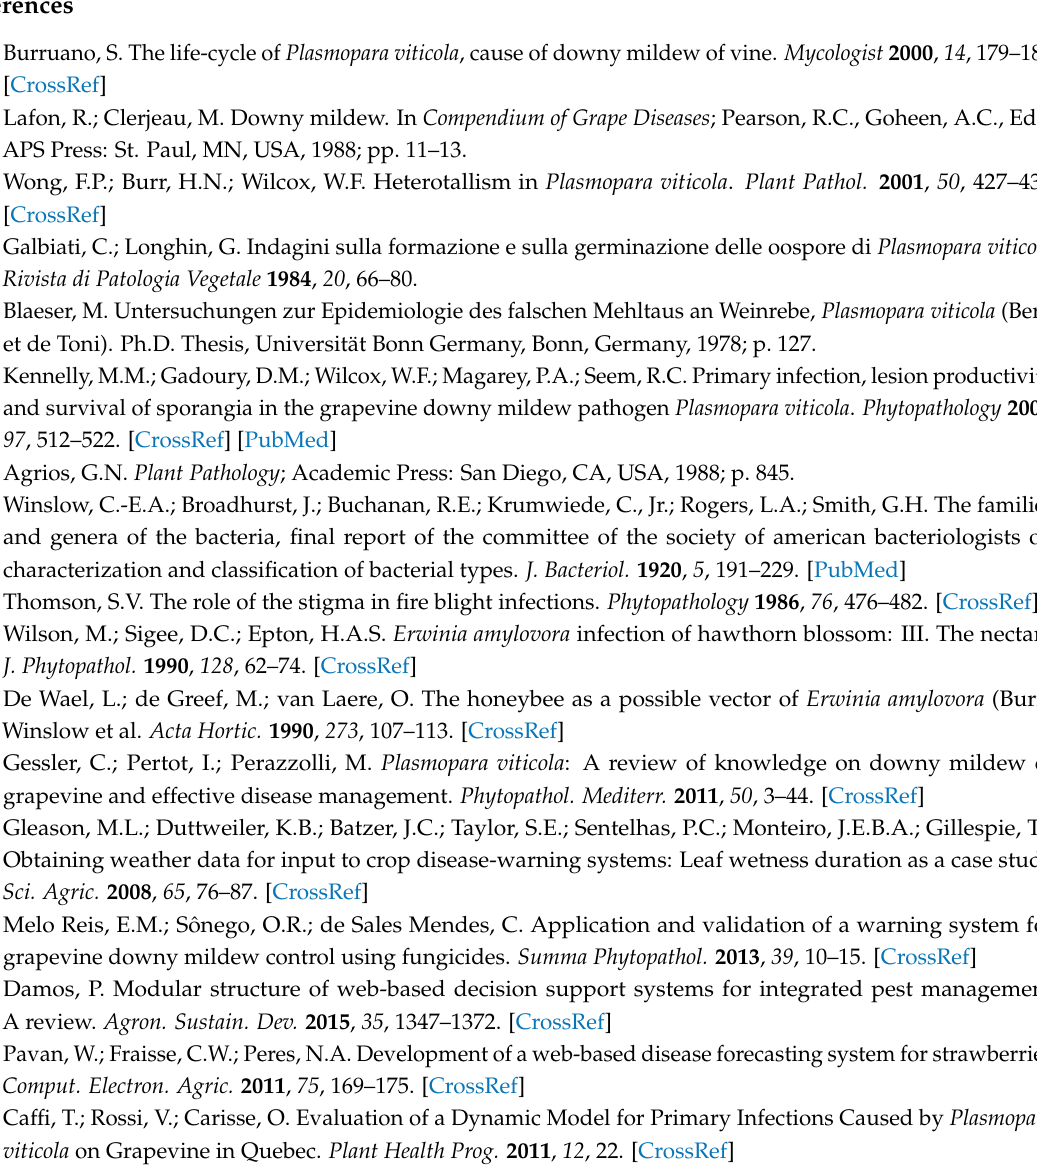
Figure A2. Errors of 2 m HRES maximal air temperature depending on lead time.